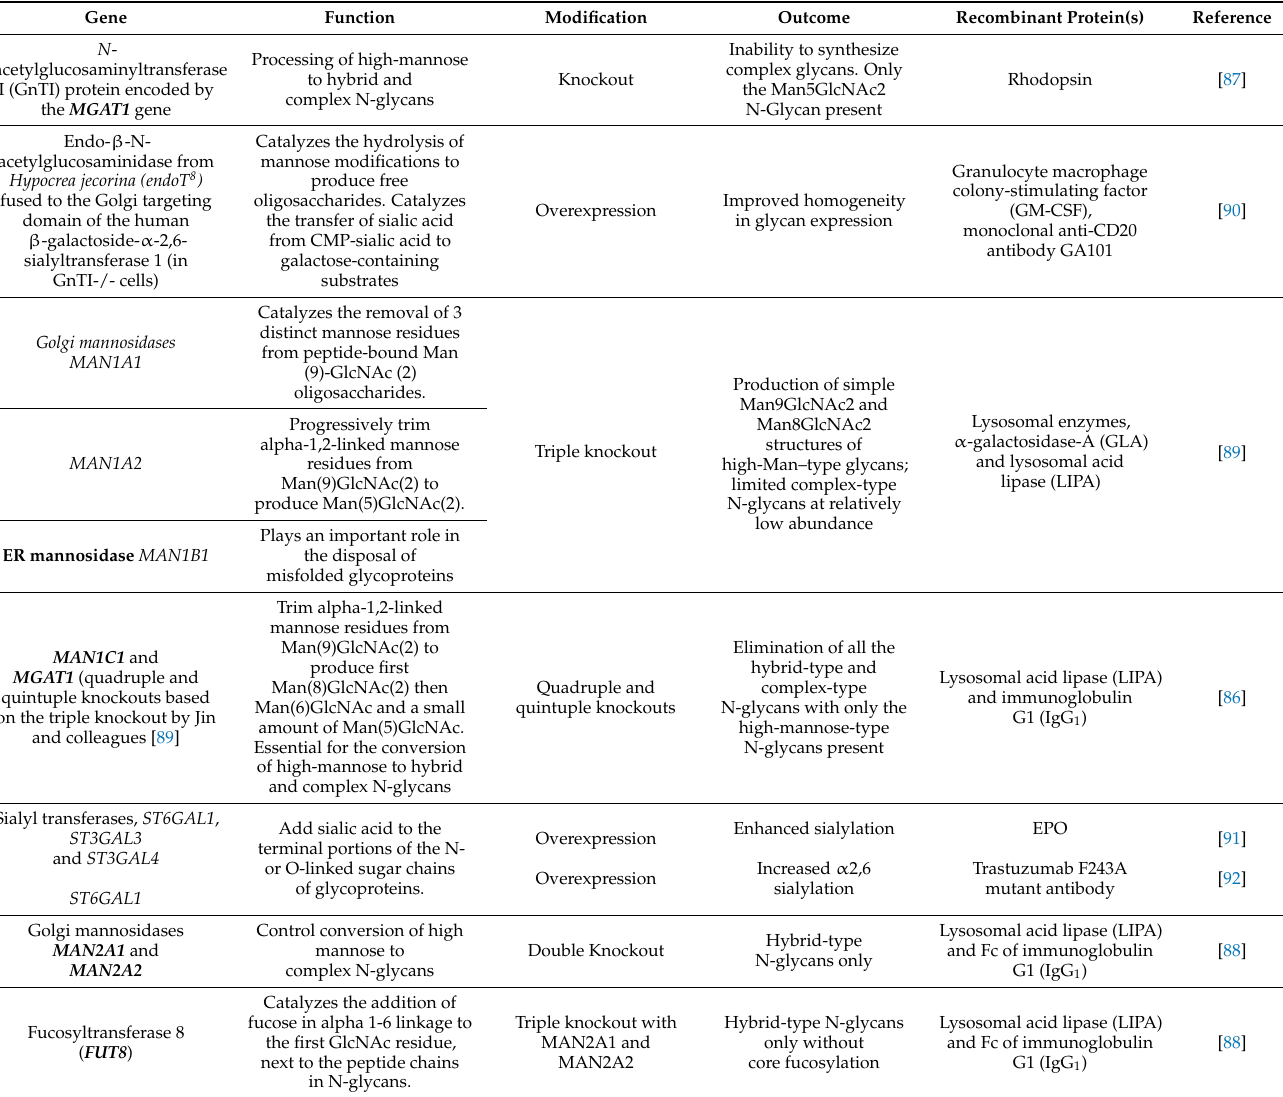
Table 5. Genes that have been engineered to improve glycan pattern homogeneity and glycosylation efficiency in the HEK293 cell